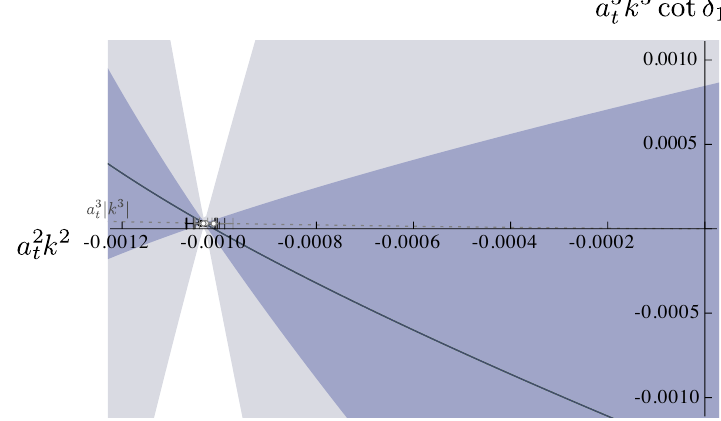
Figure 15. The P -wave part of the reference amplitude eq. (4.9) plotted as k 3 cot δ 1 . The grey points are from the moving frame A 1 irreps where S -wave also appears, the black points are from [000] T − and the other moving frame irreps. The meaning of the bands is as in figure 7. The dotted 1 line shows a 3 | k 3 | t